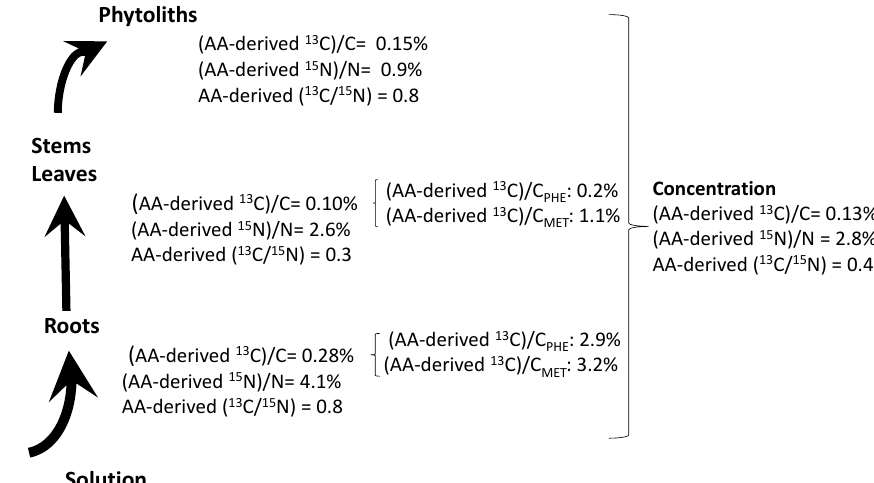
Figure 2. Concentration of AA-derived 13 C and AA-derived 15 N in bulk matter, phenylalanine (PHE) and methionine (MET) of roots, stems and leaves, and phytoliths of Festuca arundinacea grown in labeled tanks (in % of bulk C, N, PHE and MET).